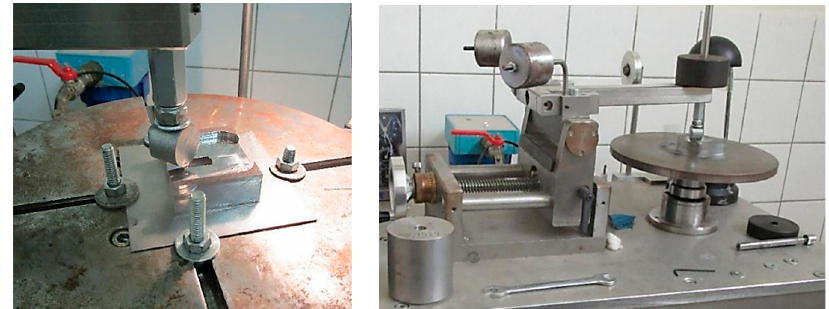
Figure 13. The samples clamping in the holder ( left ) and the complex view on tribometer ( right ).